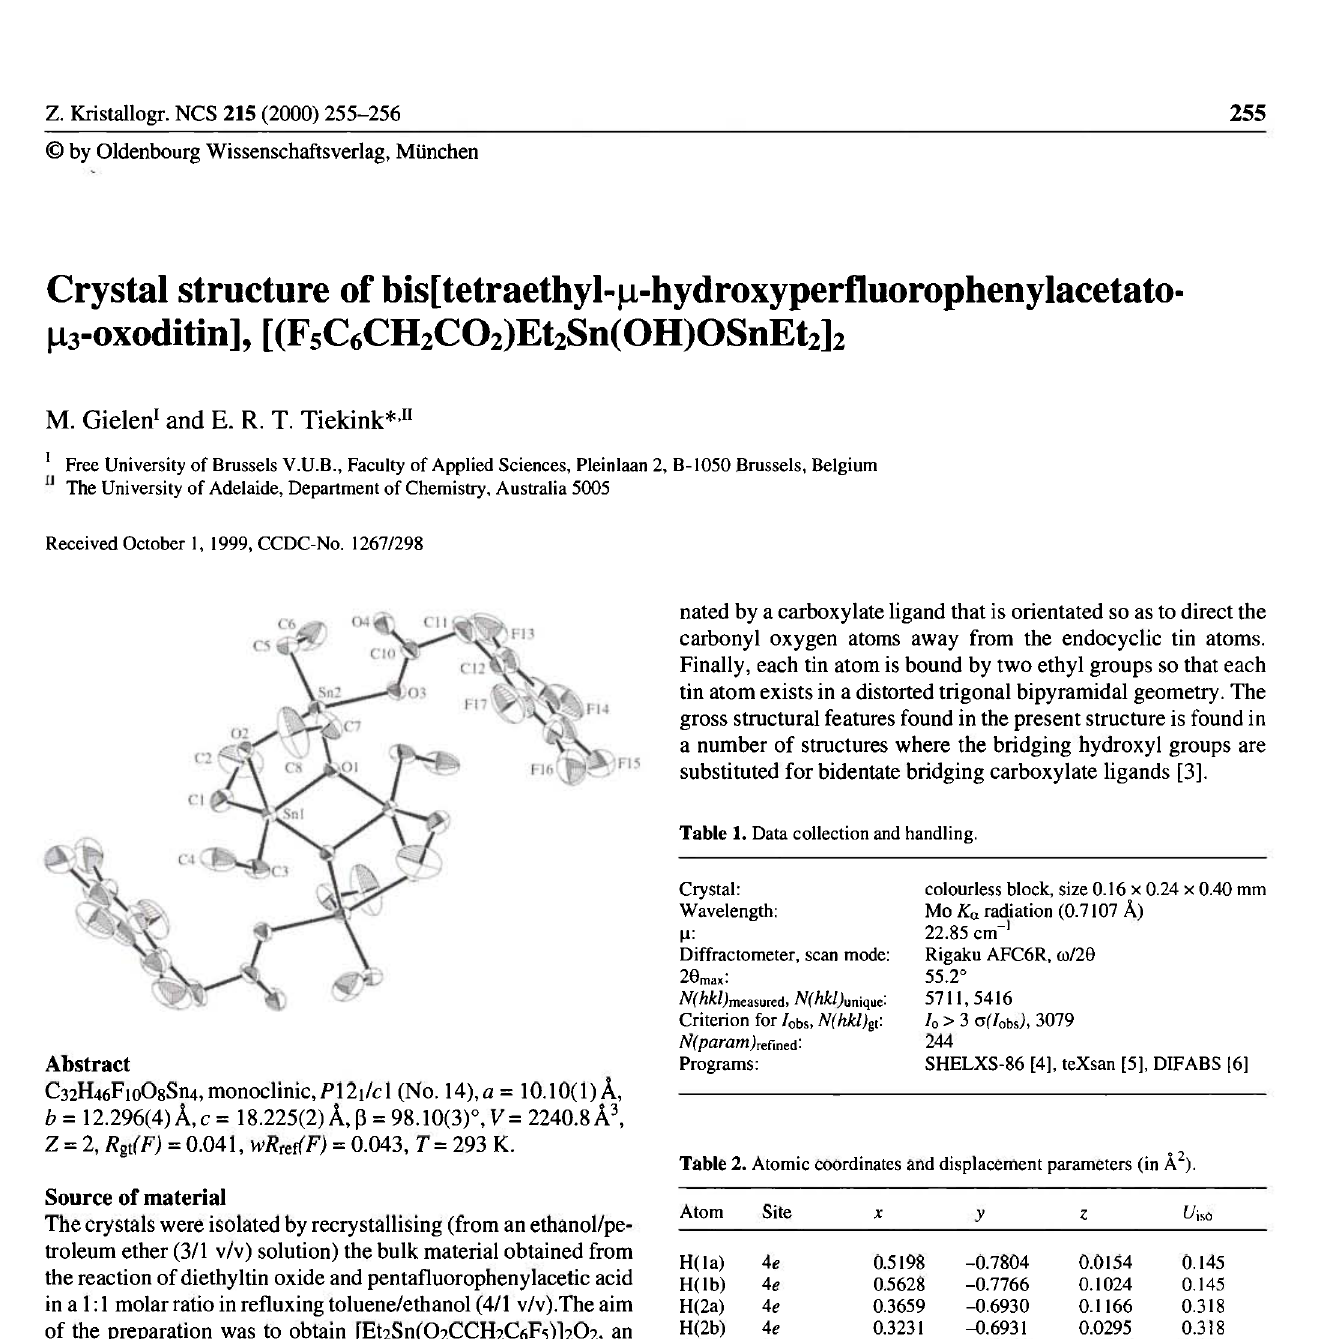
Table 2. Atomic coordinates and displacement parameters (in Ä 2